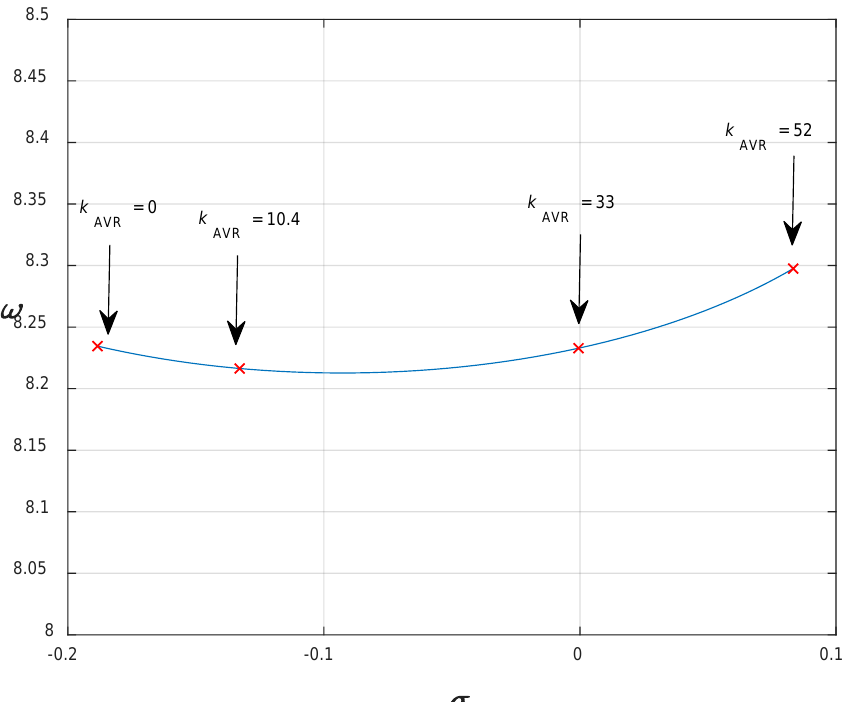
Figure 10. Influence of exciter and AVR gain k AVR on the local mode eigenvalue of the hydro-generator with nominal power 158 MVA for nominal operating point S = 158 MVA, cos φ = 0.9.